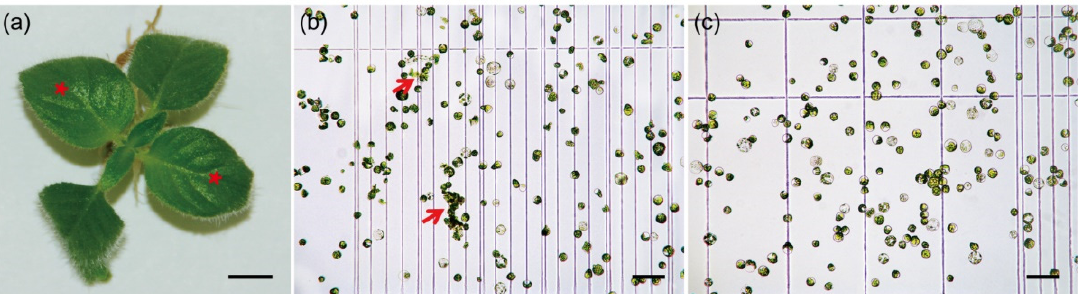
Figure 1. Protoplast isolation from C. pumila leaf mesophyll. ( a ) Young leaves (red stars) that were experiencing ongoing active growth were used for protoplasts isolation. ( b ) Protoplasts isolated using enzymatic buffers containing pectinase. The red arrows indicate incomplete digested tissues. ( c ) Protoplast isolated with pretreatment procedure and enzymatic buffers containing pectinase. Scale bars, ( a ) 0.5 cm; ( b ) and ( c ) 100 μ m. Table 1. Effects of different enzyme combinations on protoplast yield from C. pumila leaves. Pectinase (%) Cellulase (%) Macerozyme (%)